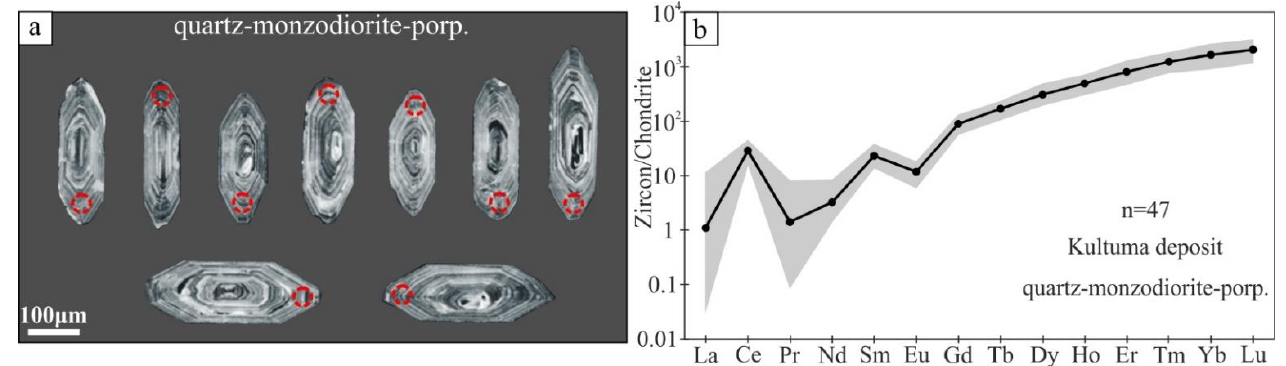
Figure 7. ( a ) — Cathodoluminescence (CL) images of representative zircon grains with laser spots (red circles) from the magmatic rocks of the Kultuma deposit; ( b ) — chondrite-normalized REE patterns for zircons from the magmatic rocks of the Kultuma deposit.